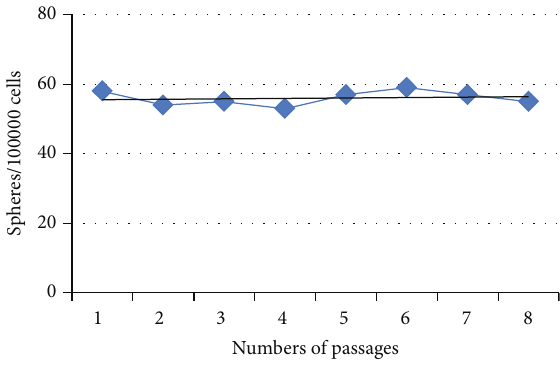
Figure 8: Sphere frequency assay.